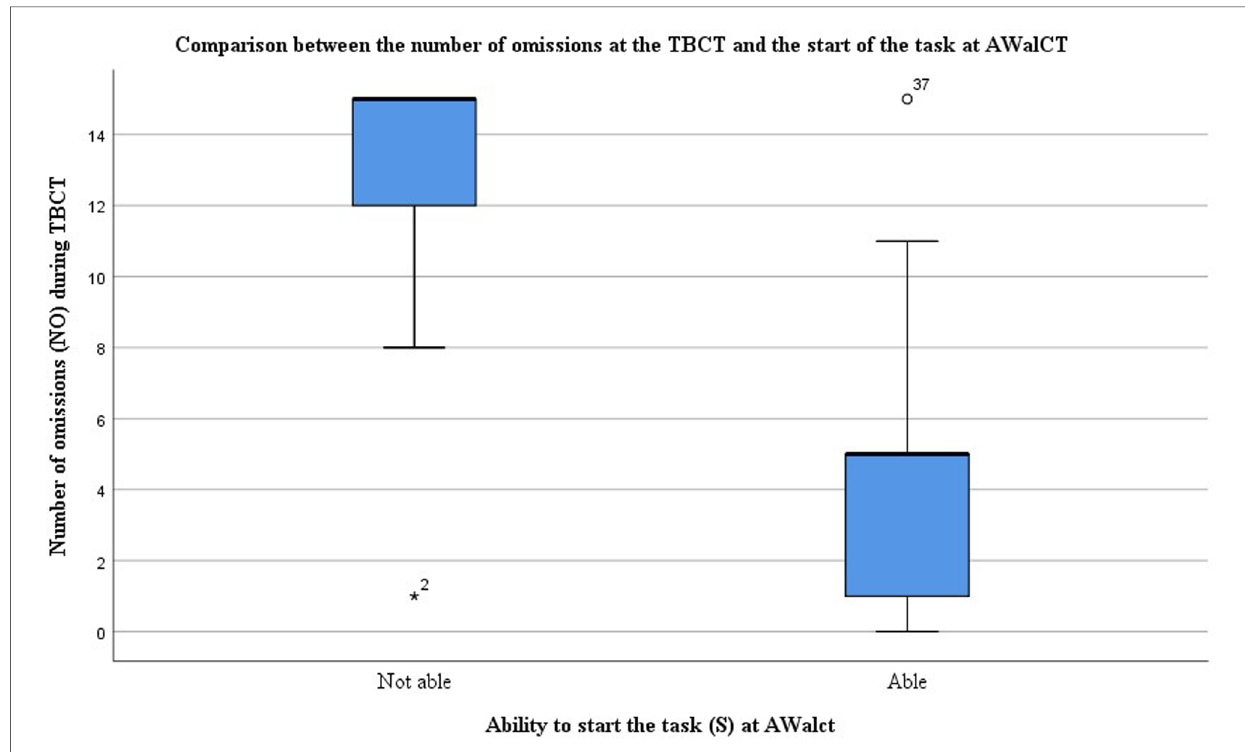
FIGURE 2 Boxplot comparing the number of omissions at the TBCT and the start of the task at AWalCT. The graph shows marked differences between subjects able and unable to start the task, being the median values of 5 and 15 omissions,